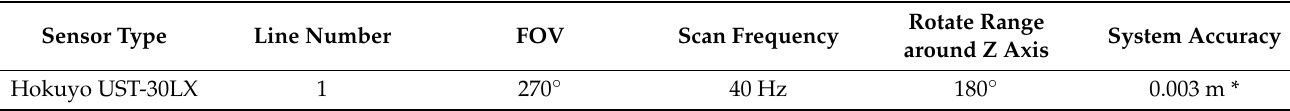
Table 2. The parameters of the portable laser